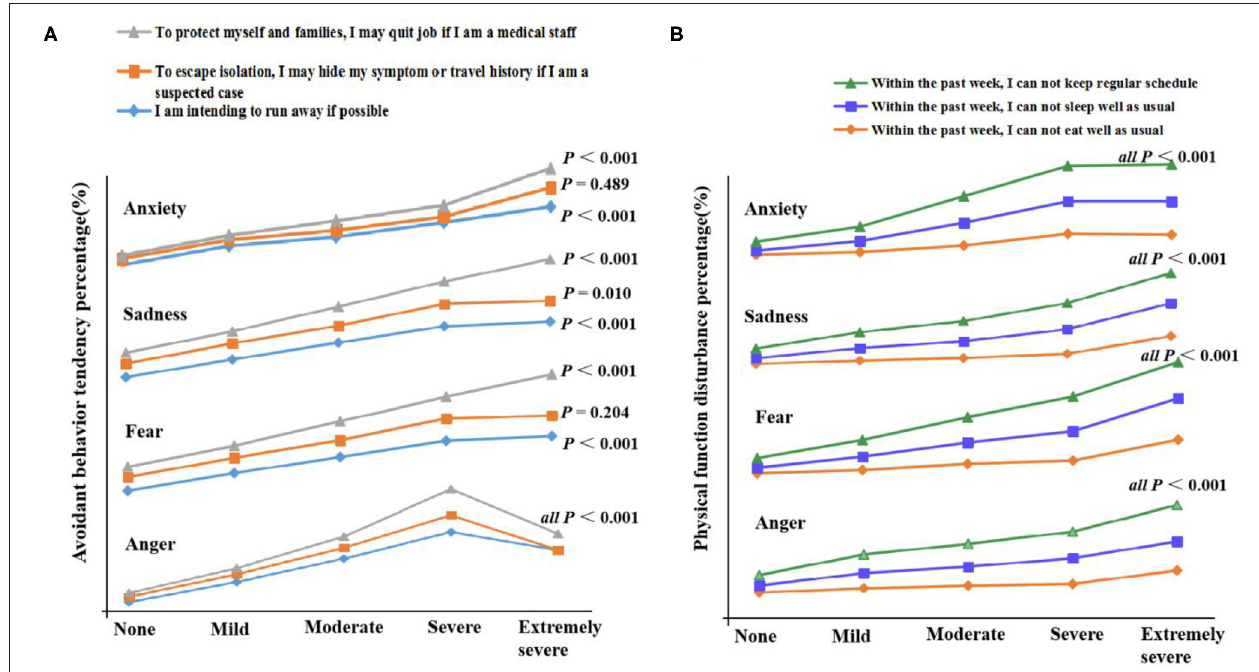
FIGURE 4 | The effects of negative emotions on avoidant behavior tendency and disturbed physical function. (A) Avoidant behavior tendency. (B) Disturbed physical function.